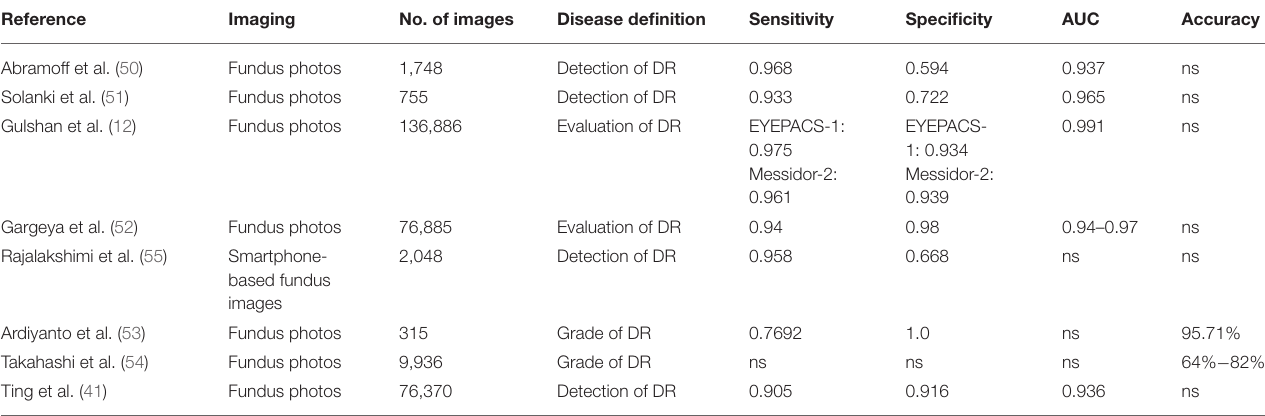
TABLE 2 | Summary of studies about AI and diabetic retinopathy. Reference